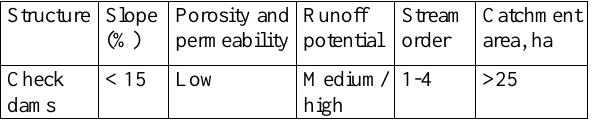
Table 2 Adopted specifications from IMSD guidelines for Check dams